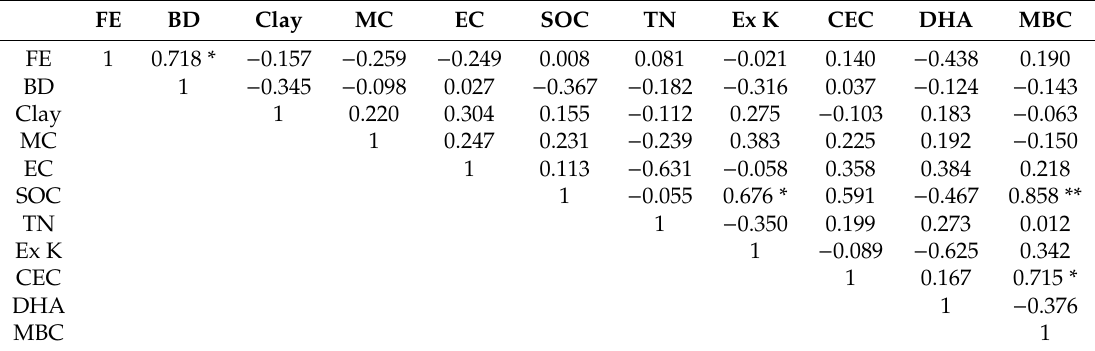
* Correlation is significant at 0.05 level (2-tailed), ** correlation is significant at 0.01 level